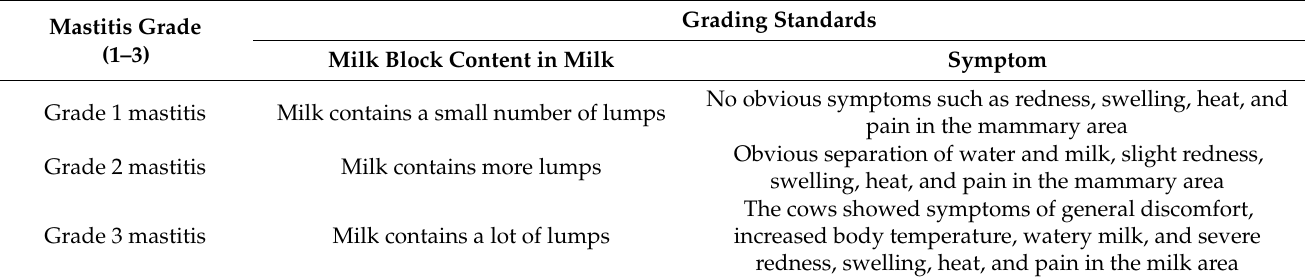
Table 2. Classification of clinical mastitis.